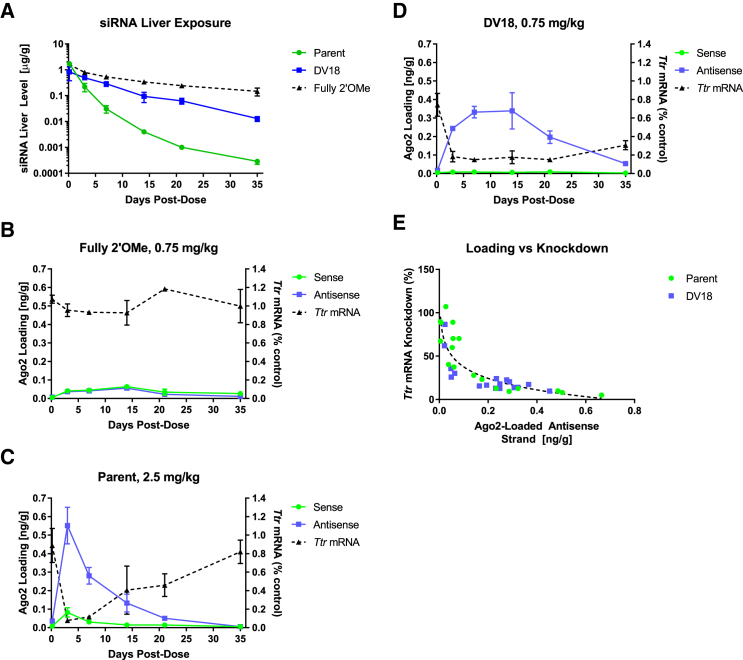
In Vivo Evaluation of Parent, DV 18, and Fully 2′-OMe Conjugates Targeting Ttr(A) Time course analysis of antisense strand liver levels (μg/g, microgram antisense strand per gram of liver) from mouse cohorts (n = 3/group/time) dosed with Parent (green line, 2.5 mg/kg), DV 18 (blue line, 0.75 mg/kg), or fully 2′-OMe (black dashed line, 0.75 mg/kg) conjugates targeting Ttr. (B–D) Time course analyses of Ttr mRNA knockdown (dashed black line) and sense (green line) and antisense (blue line) Ago2 loading (ng/g, nanogram sense or antisense strand per gram liver) for parent (B), DV 18 (C), and fully 2′-OMe (D) conjugates. Ttr mRNA levels were normalized to Gapdh mRNA for each animal and then to PBS control animals. (E) Comparison plot of Ago2-loaded antisense with Ttr mRNA knockdown for parent (green circles) and DV 18 (blue squares) conjugates. Semi-log lines of best fit are overlaid. Error is represented as the SD.